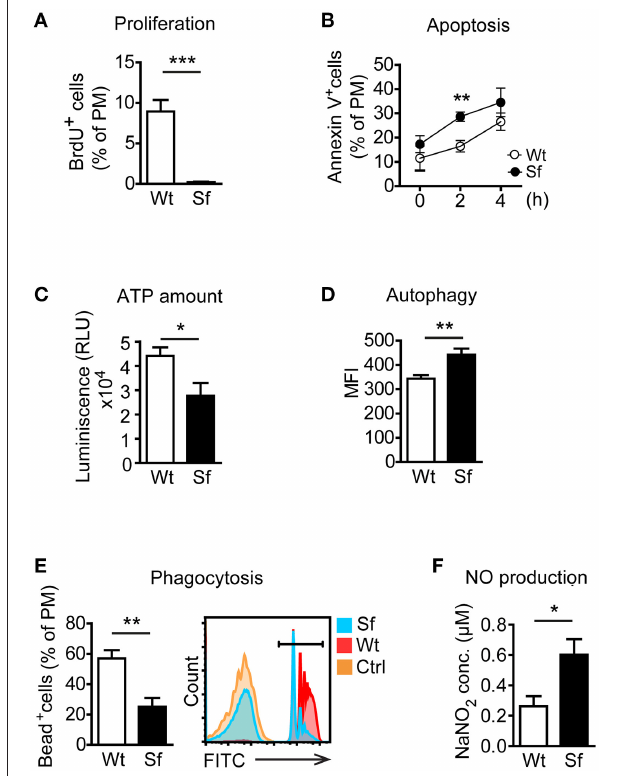
FIGURE 2 | Peritoneal macrophages in scurfy mice acquire state of activation and exhaustion. (A) In vivo proliferation ( n = 4, one representative experiment out of three) and ( B) apoptosis (Annexin V staining; n = 9–13 per time-point) of peritoneal macrophages (PM) in control (Wt) and scurfy (Sf) mice measured by flow cytometry. (C) ATP amount in purified PM quantified by CellTiter-Glo ( n = 3–5). Flow cytometry analysis of (D) autophagy ( n = 4–5, one representative experiment out of two) and (E) phagocytosis in vivo ( n = 5) in Wt and Sf PM. (F) Nitrogen oxide (NO) secretion by purified PM measured by Griess assay ( n = 4–8). Statistical analyses were performed using unpaired Student’s t -test, * p < 0.05, ** p < 0.01, *** p <